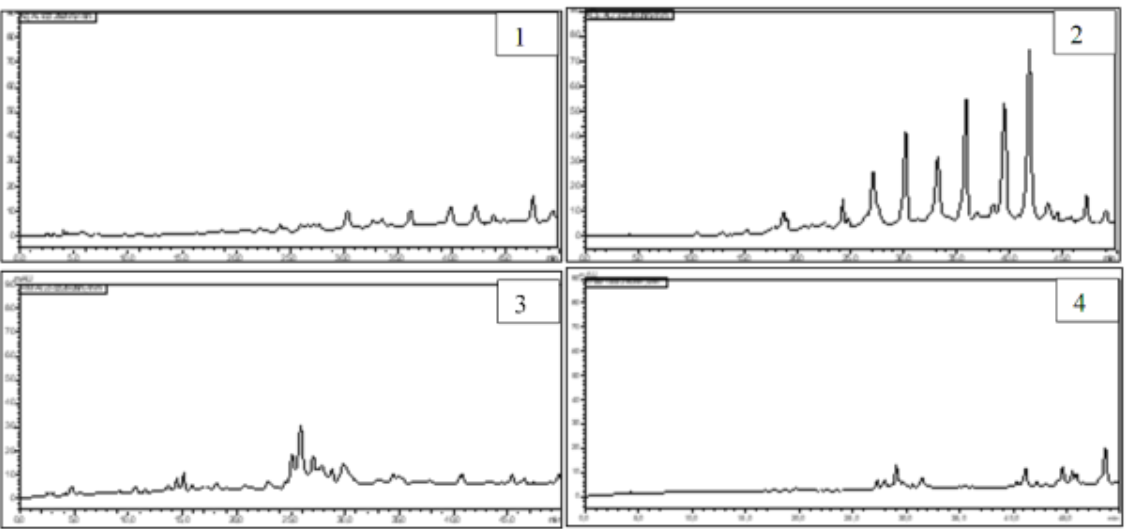
Figure 1. Representative high performance liquid chromatography profile of Ajuga iva extracts: Aqueous (1), Ethyl acetate (2), Hydromethanolic (3), Butanolic